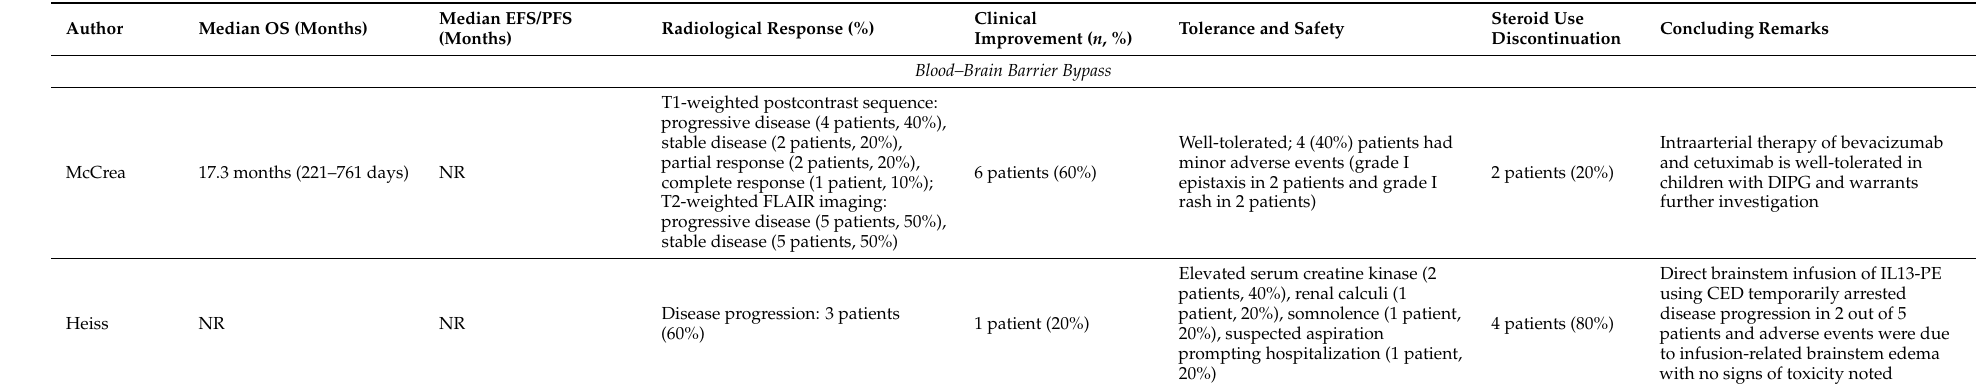
Table 3. Efficacy and safety outcomes of the